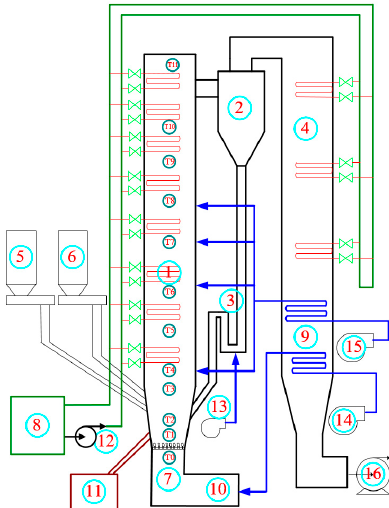
Figure 4. Schematic diagram of main equipment of the circulating fluidized bed (CFB) test bench. (1) Combustion chamber; (2) Cyclone separator; (3) Loop-seal recycle device; (4) Tail flue; (5) Fuel feeder; (6) Limestone feeder; (7) Fluidization air chamber; (8) Cooling water system (9) Air preheater; (10) Ignition unit; (11) Ash discharge system; (12) Feed pump; (13) High-pressure fluidized blower; (14) Primary fan; (15) Secondary air fan; (16) Draught fan.